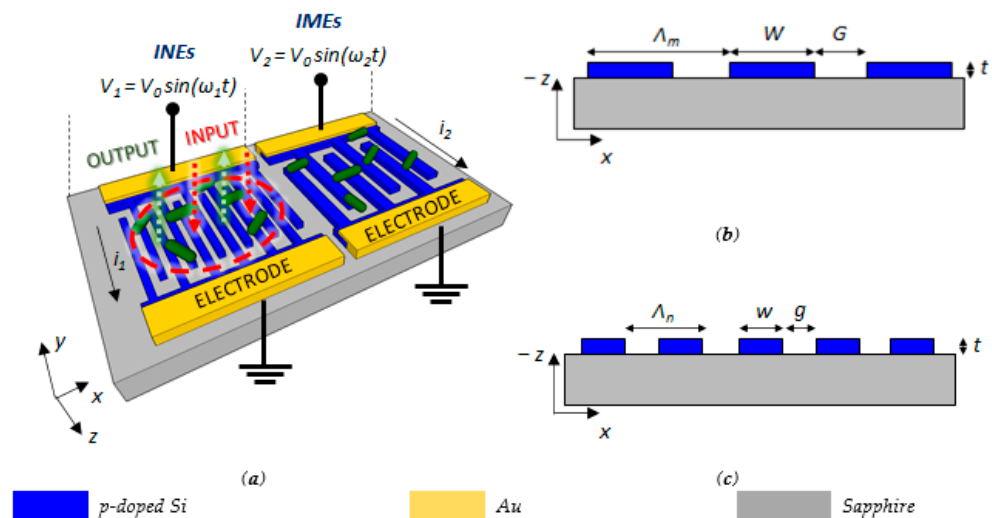
Figure 1. ( a ) Configuration of the dual array of interdigitated micro- and nanoelectrodes in SOS technology for the electrical detection of bacteria (in green) growth and metabolism. The section with nanoelectrodes represents an optical sub-wavelength grating resonating at a specific wavelength when top illuminated, so enabling a simultaneous optical and electrical detection of bacteria deposition; ( b ) Interdigitated Micro Electrodes ( IMEs ), where W is the width of the silicon layer ( W >> w ), G is the gap between electrodes ( G >> g ); and Λ m is the IMEs period; ( c ) Interdigitated Nano Electrodes ( INEs ), where w is the width of the silicon layer, g is the gap between electrodes; and Λ n is the INEs period. The output signal of the Guided Mode Resonance (GMR) structure consists of the reflected optical signal (green arrows) by illuminating the optical section with TE -polarized light (red arrows).